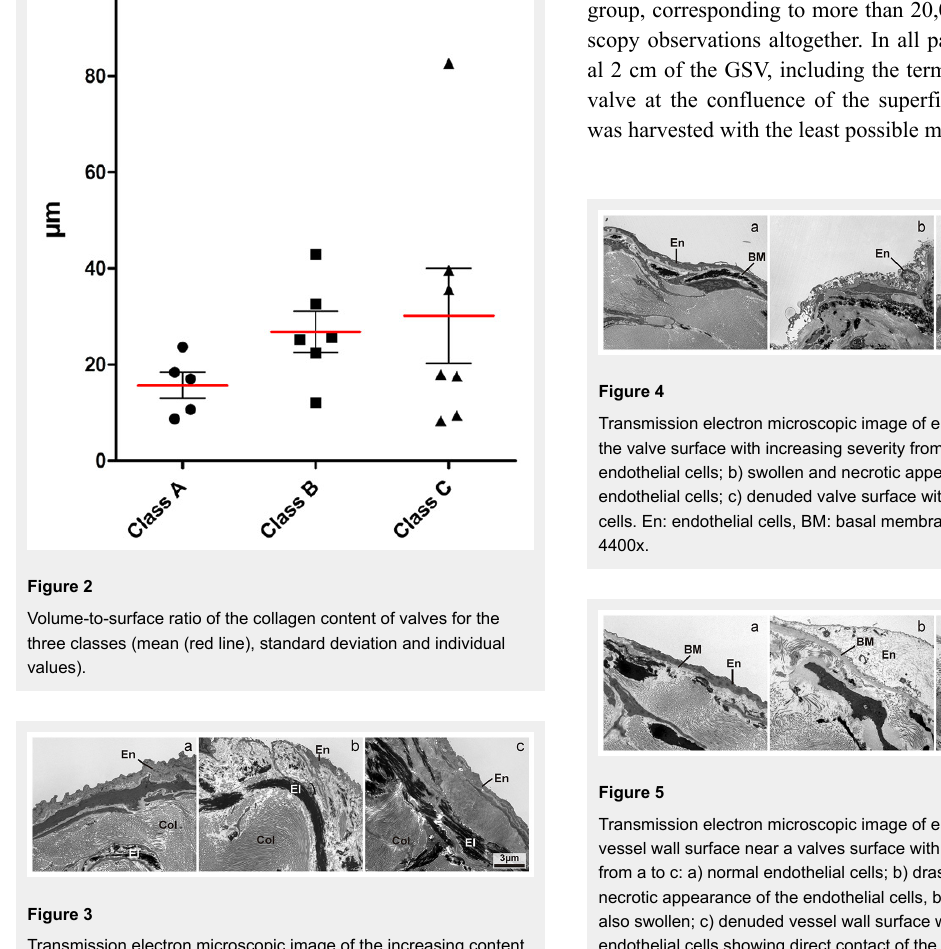
Transmission electron microscopic image of the increasing content in elastin in valves from classes A to C. En: endothelial cells, El: elastin, Col: collagen. Magnification: 4400x.